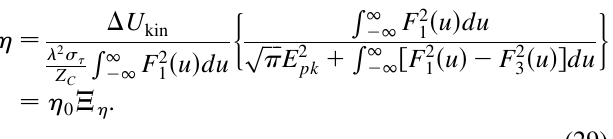
. The sum in Eq. (22) was truncated at n (cid:1) 50 (cid:24)